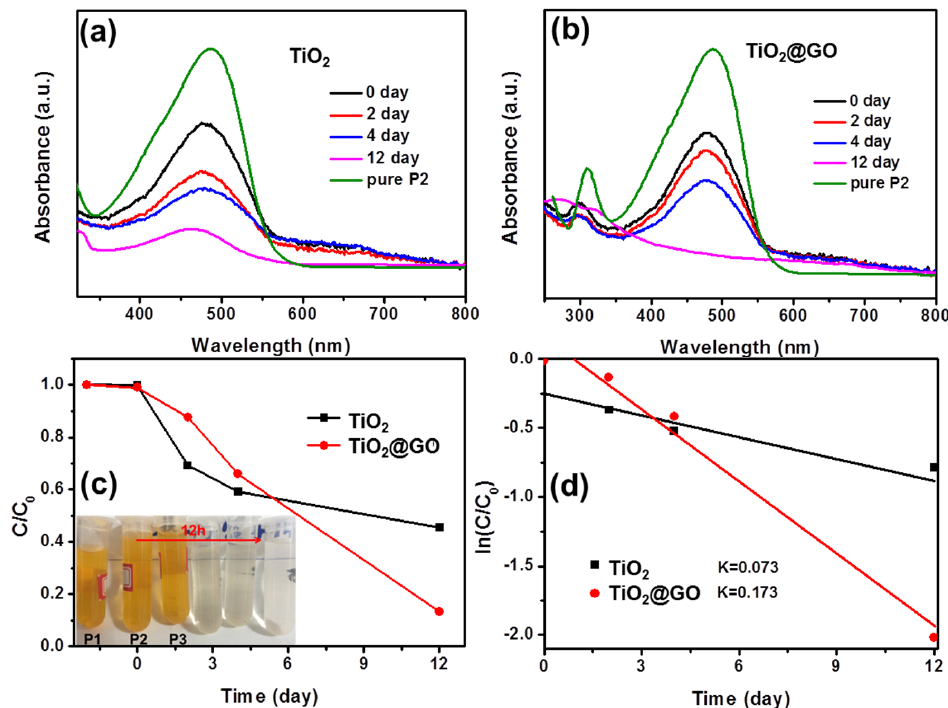
Figure 5. P2 decomposition by ( a ) TiO 2 and ( b ) TiO 2 @GO with the illumination of natural light; ( c ) Comparison of photocatalytic activities of TiO 2 and TiO 2 @GO; ( d ) Dependence of ln(C/C 0 ) on time. The inset diagram showed water-soluble polymers degradation within 12 days under natural light.